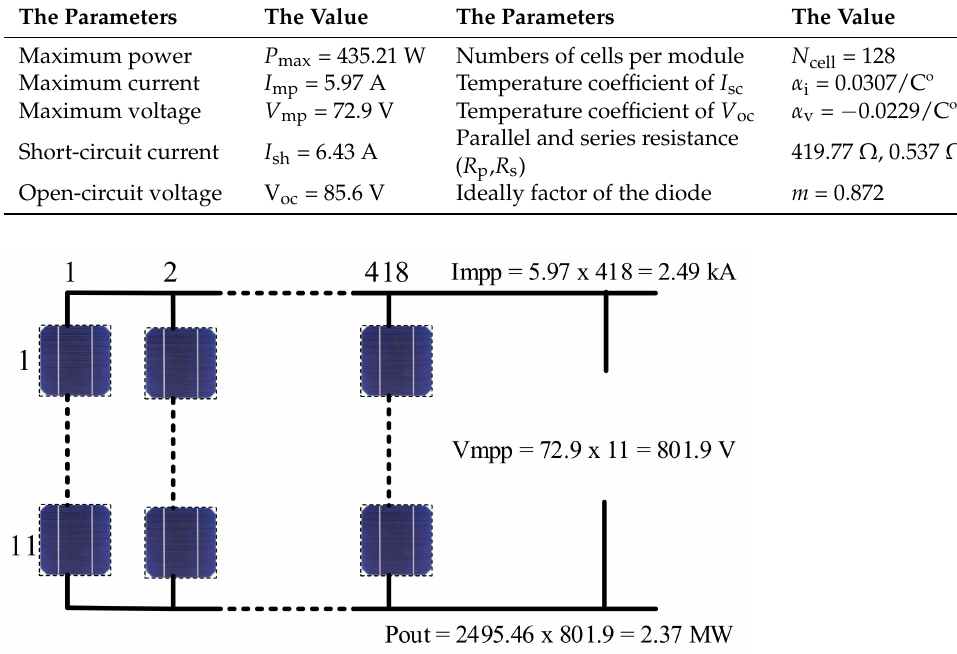
Figure 3. The PVPP array